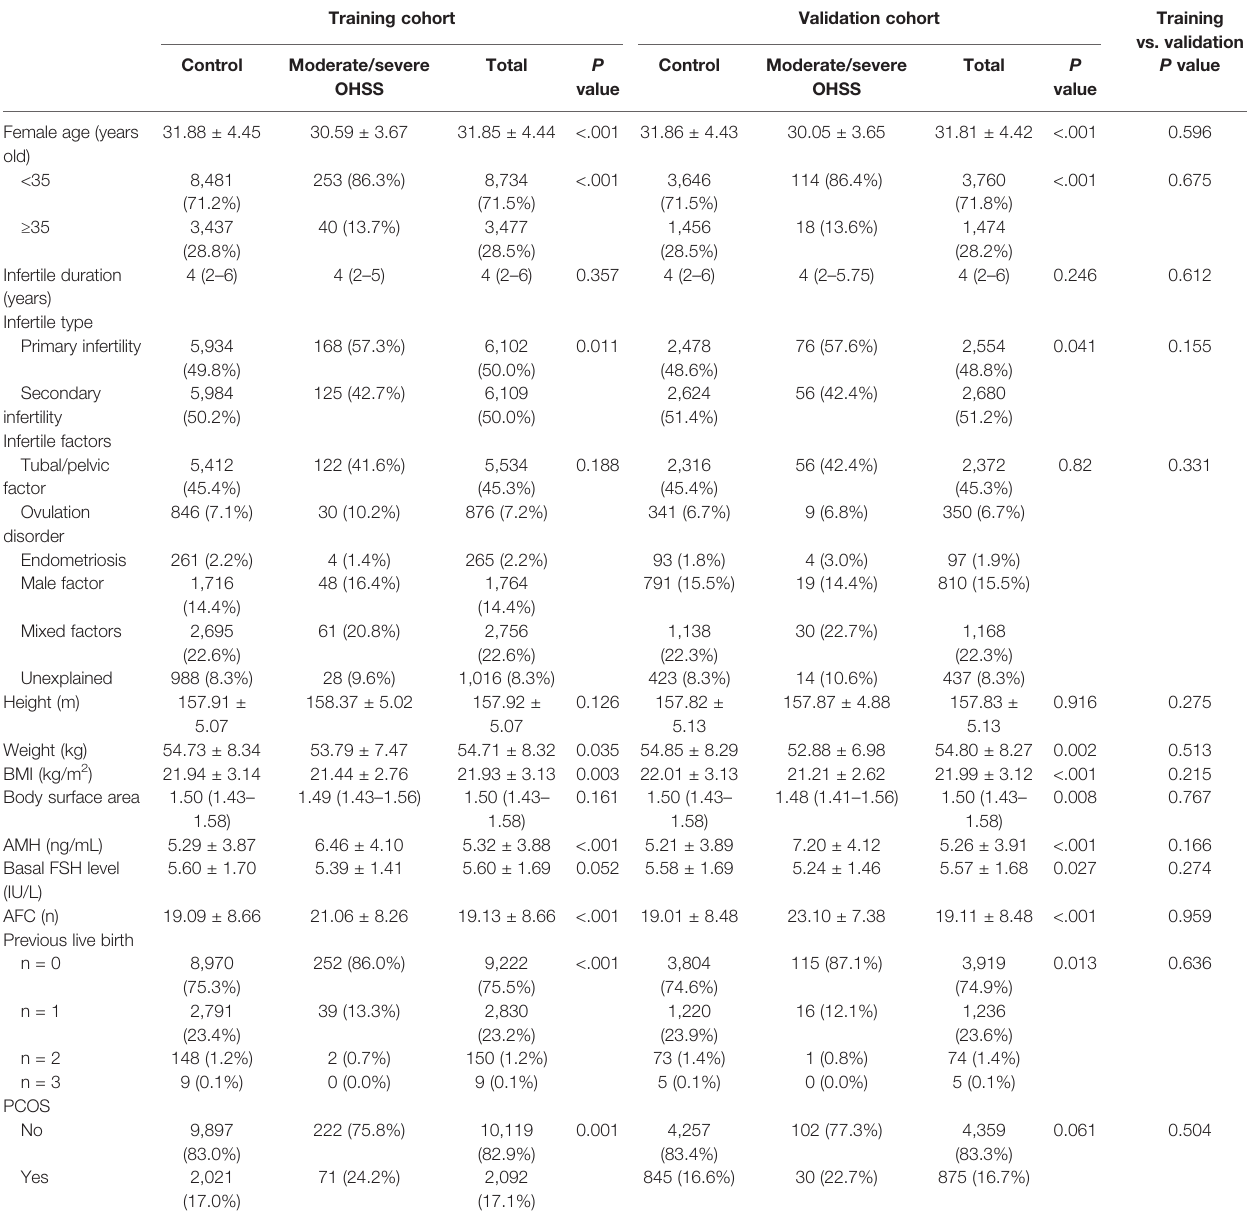
TABLE 1 | Baseline clinical characteristics of the training and validation cohorts. Training cohort Validation cohort Training